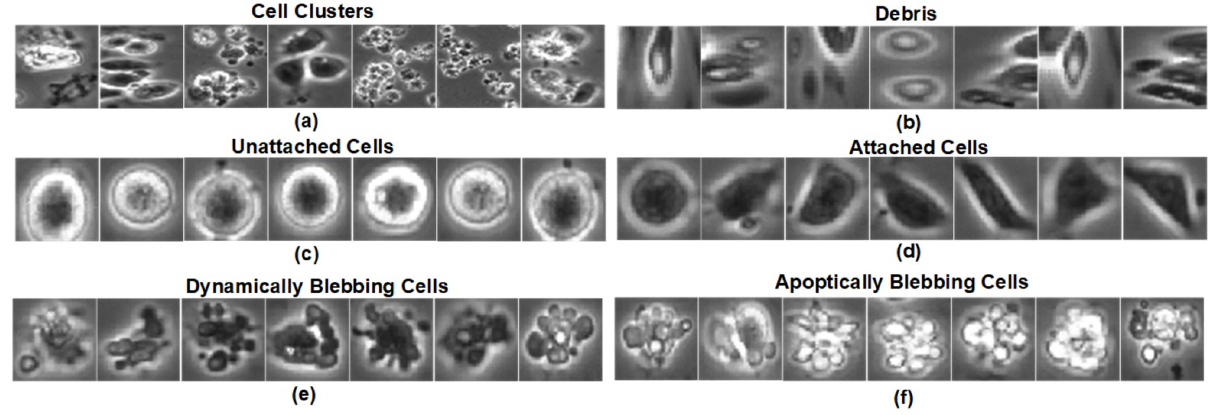
Fig 2. Phase contrast images for the six different classes of hESC obtained from the Nikon BioStation IM.